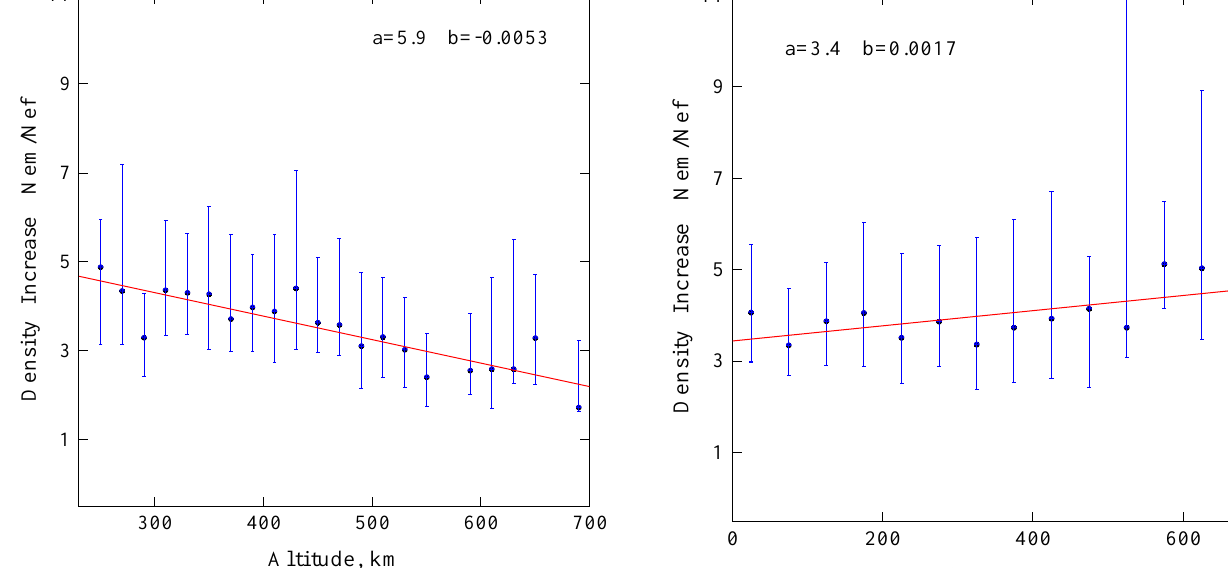
Fig. 8. Relative density increase in the polar cliff as function of geomagnetic activity. The format of data presentation corresponds to that in Fig. 7, except that the altitude is replaced by the AE6 index. Note that the data refer to a geographic longitude of 0 ◦ and an altitude of